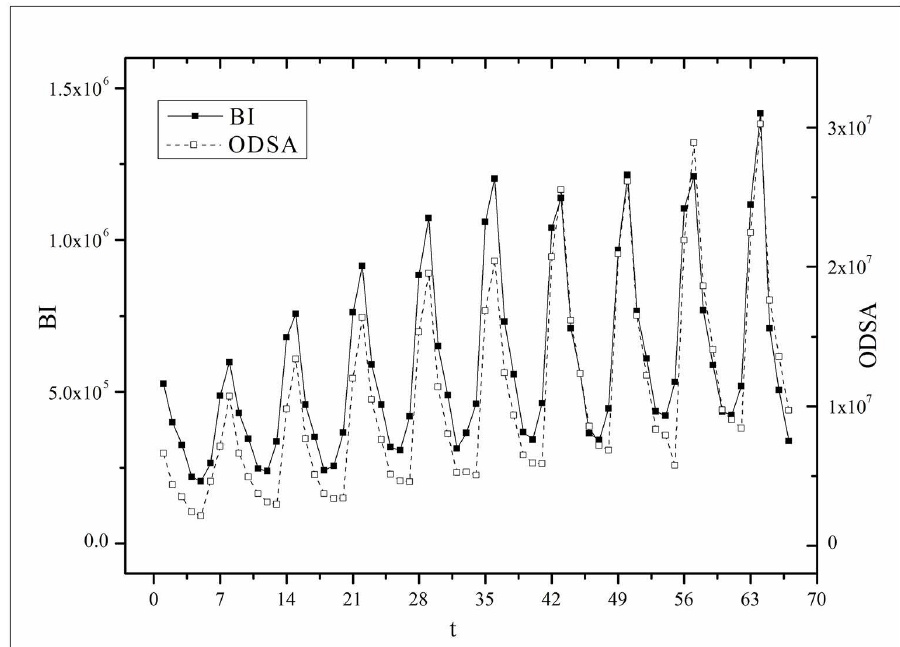
Fig 10. Correlation analysis of the Heirs dataset.